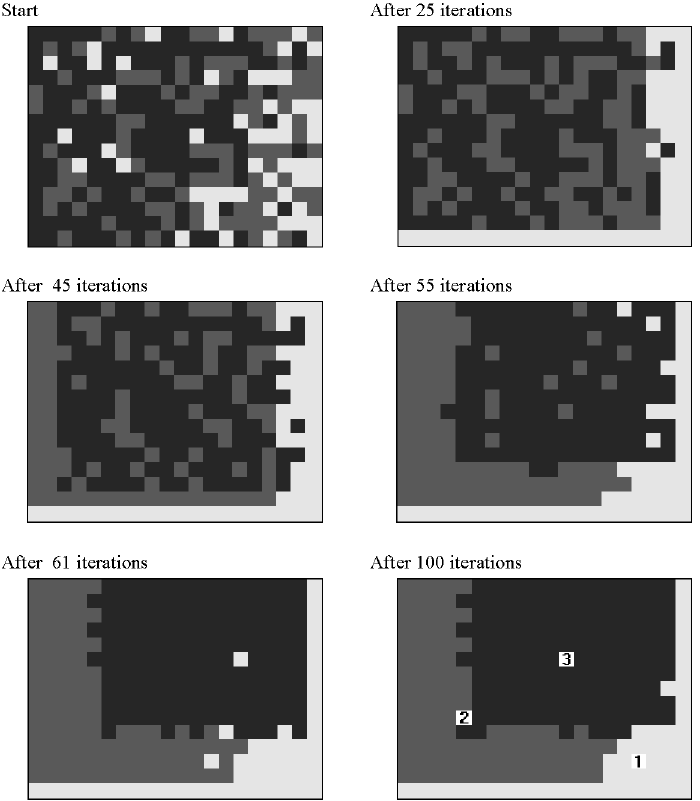
FIGURE 5 Topology from Example